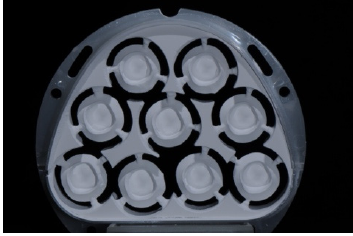
Figure 4. Zirconia blank with milled secondary crowns of 0° taper angle.